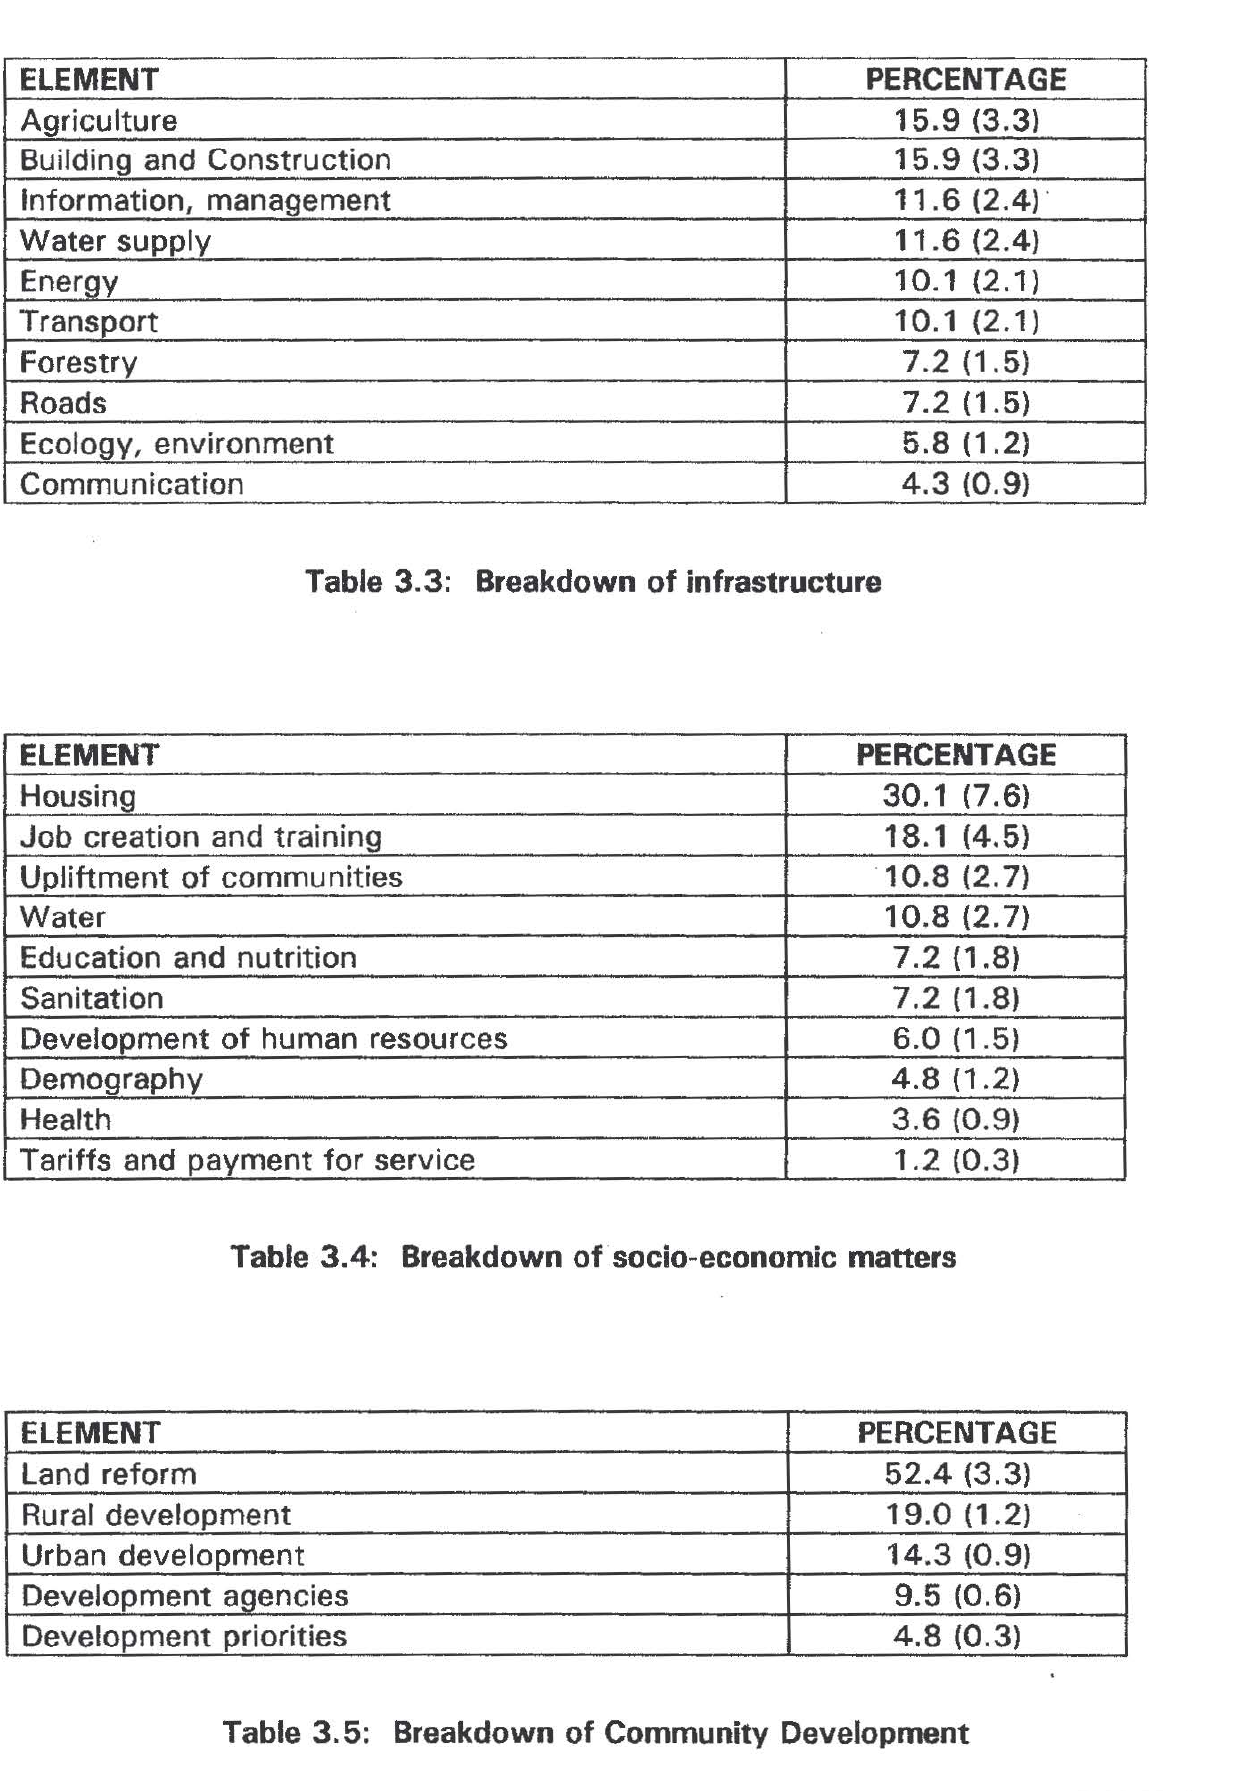
Table 3.5: Breakdown of Community